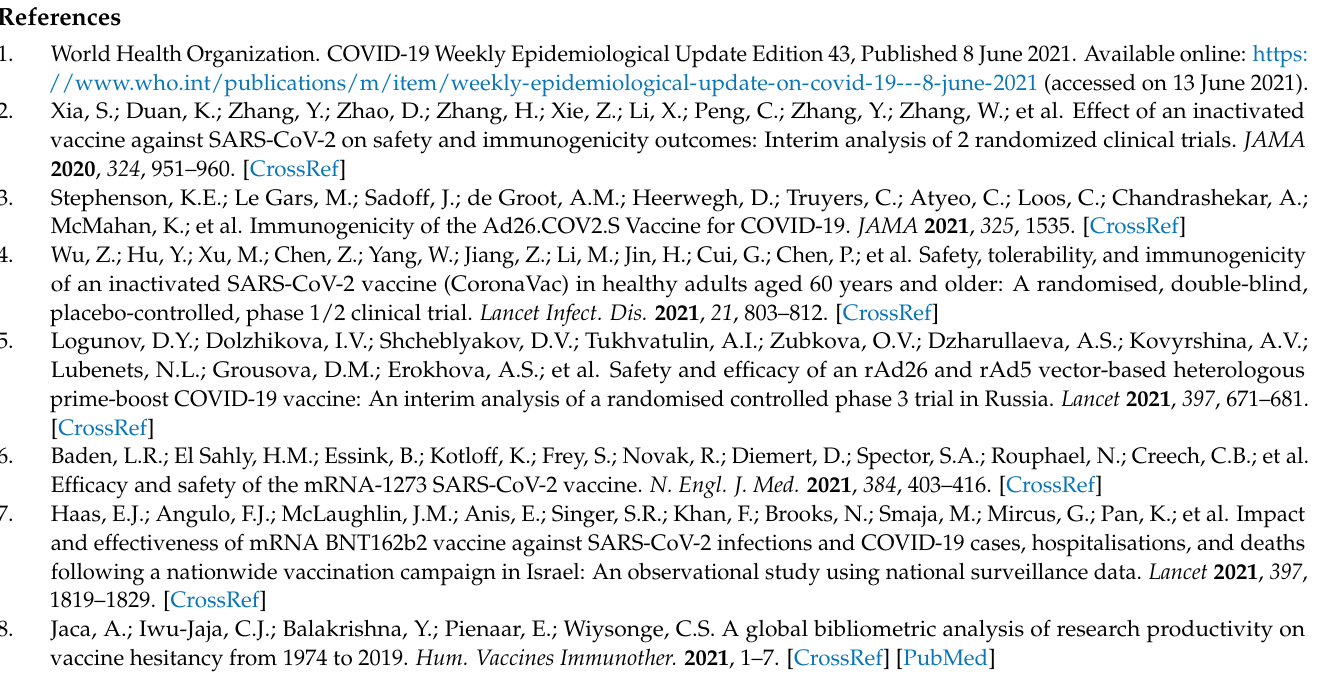
Table S1: Detailed adverse events in 312 vaccines after the first dose vaccine. Table S2: Detailed adverse events in 163 vaccines after the second dose